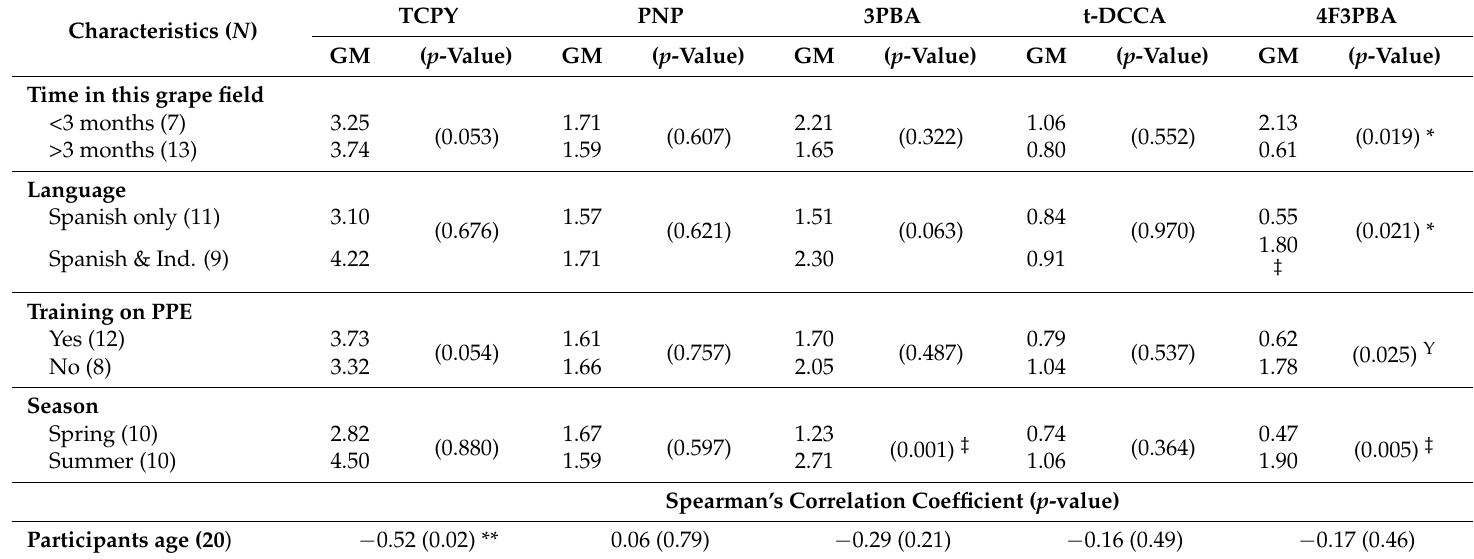
Table 6. The urine metabolite concentrations ( µ g/g of creatinine) and pesticide exposure